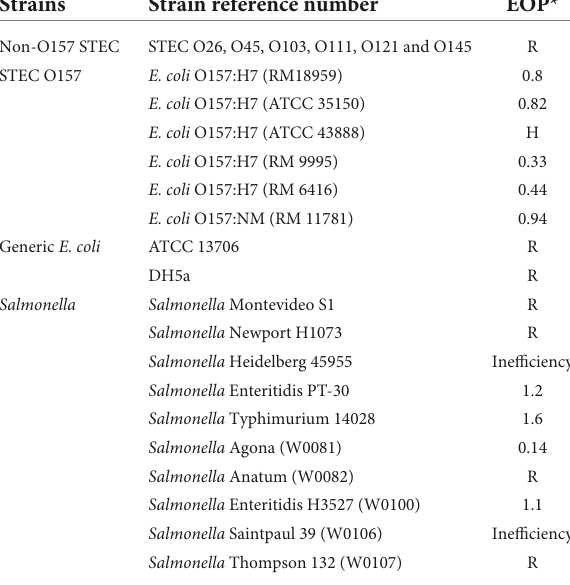
TABLE 1 Host range and efficiency of plating of phage Sa157lw against various Salmonella enterica serovars and E. coli O157:H7